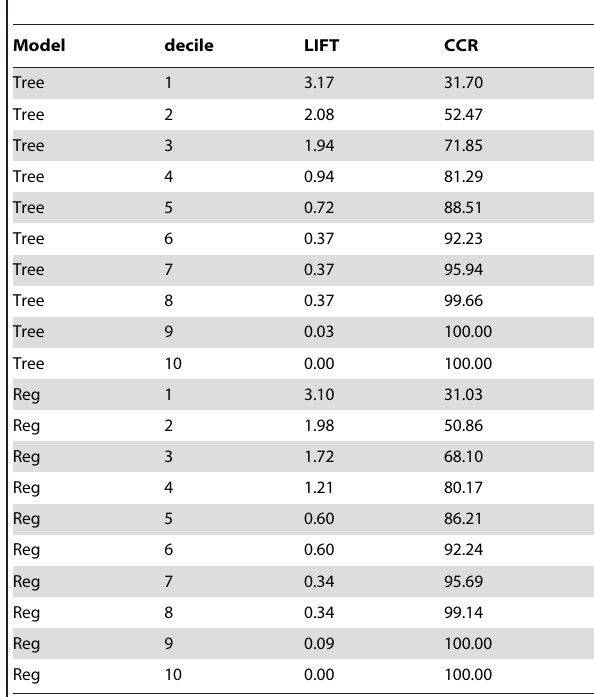
Table 10. Predictive models on C 2